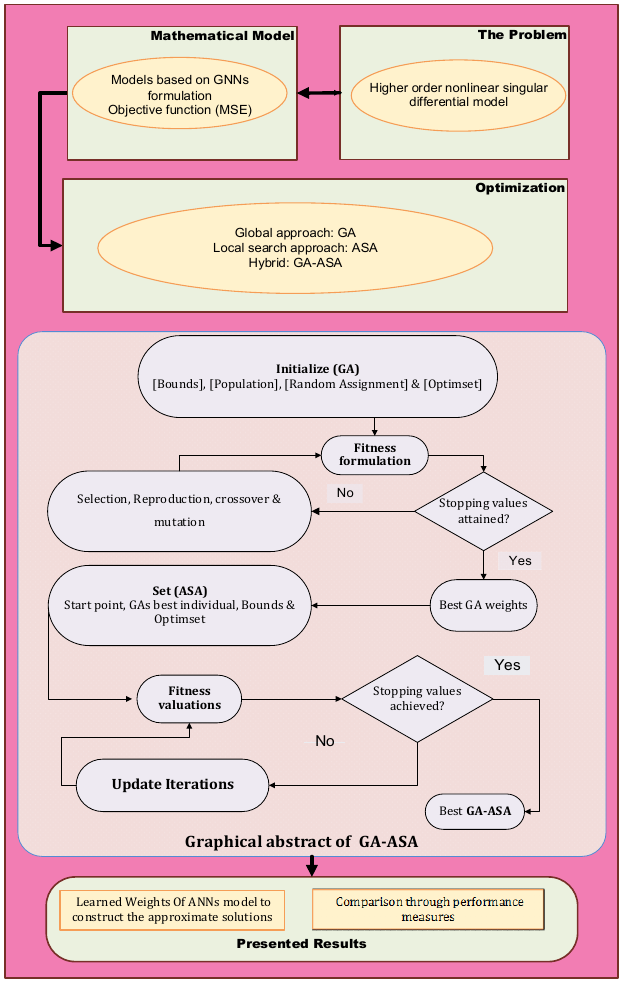
Figure 1. Framework of designed GNNs-GA-ASA methodology to solve the HO-NSDM. Global search efficiency of the GA, introduced at the end of the 19th century by Holand, is explored to obtain the weight vector ( W ) using the GNNs in the existing investigation. The population’s formulation with participant outcomes, i.e., chromosomes or individuals in GA, is accomplished by applying the real numbers with some bounds in a determinate interval. GA has been pragmatic in numerous applications, including heterogeneous bin packing optimization [37], emergency logistics humanitarian preparation [38], second order singular models [39,40], wellhead back pressure control system [41], the electricity con- sumption modeling [42], image steganography [43], collaborative filtering recommender system [44] and manufacturing systems